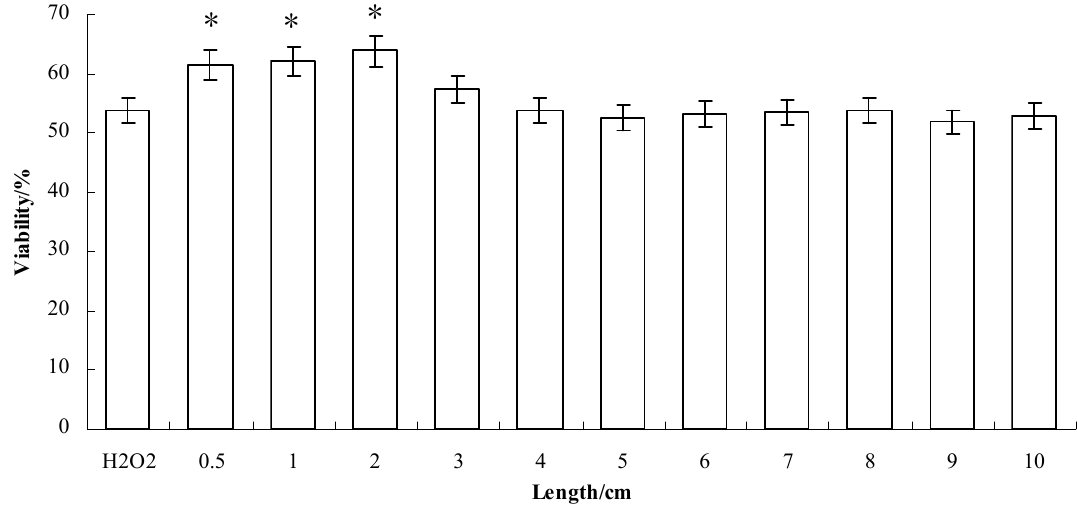
Figure 4. Effects of extracts of bean sprouts grown to different lengths on human